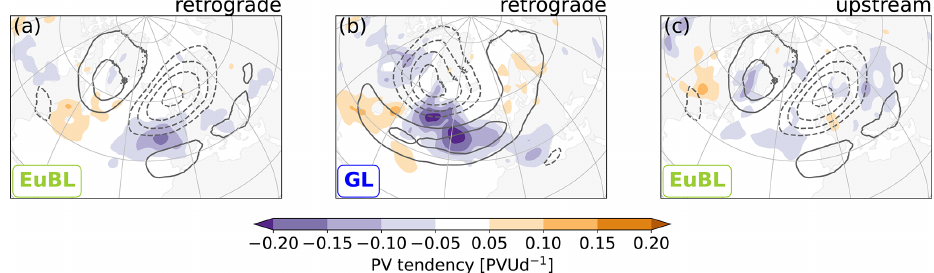
Figure 12. Same as Fig. 10, but for the divergent tendency for the retrograde cluster for EuBL (a) and GL (b) and the upstream cluster for EuBL (c) . Note the different color